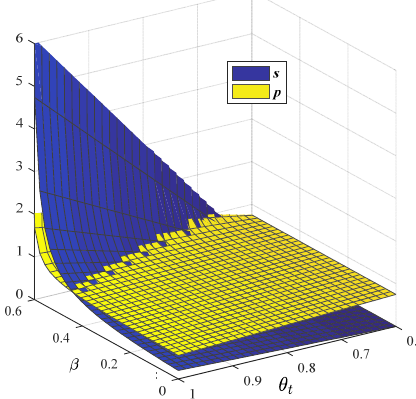
Figure 9. Price and service in Scenario D (2).